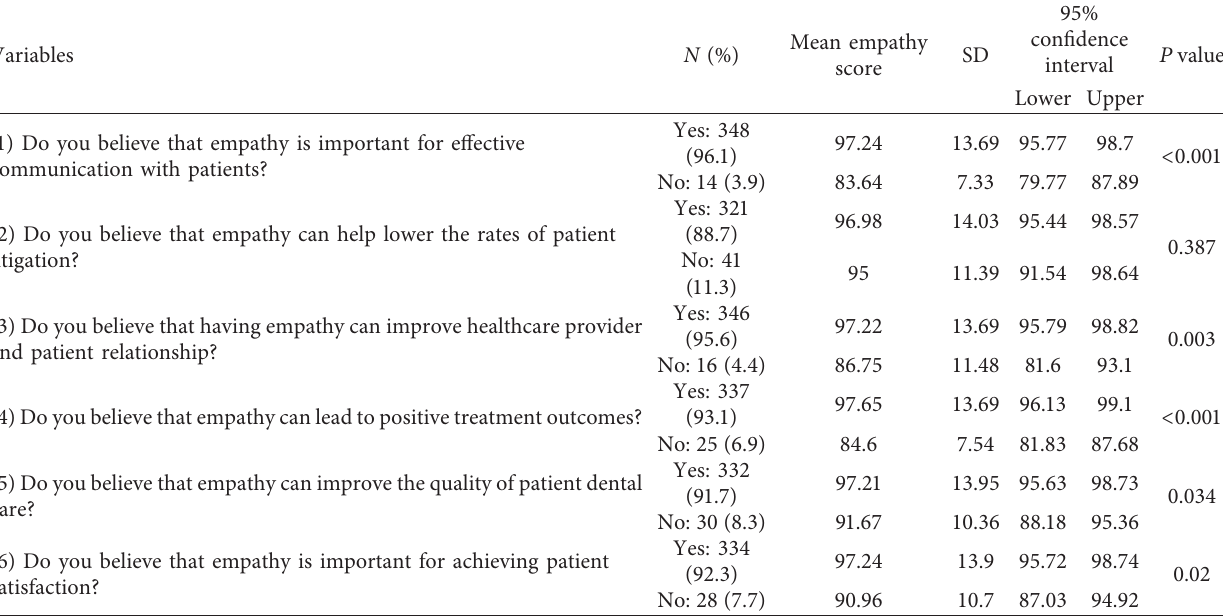
Table 2: Association between patient care factors and empathy among participants.